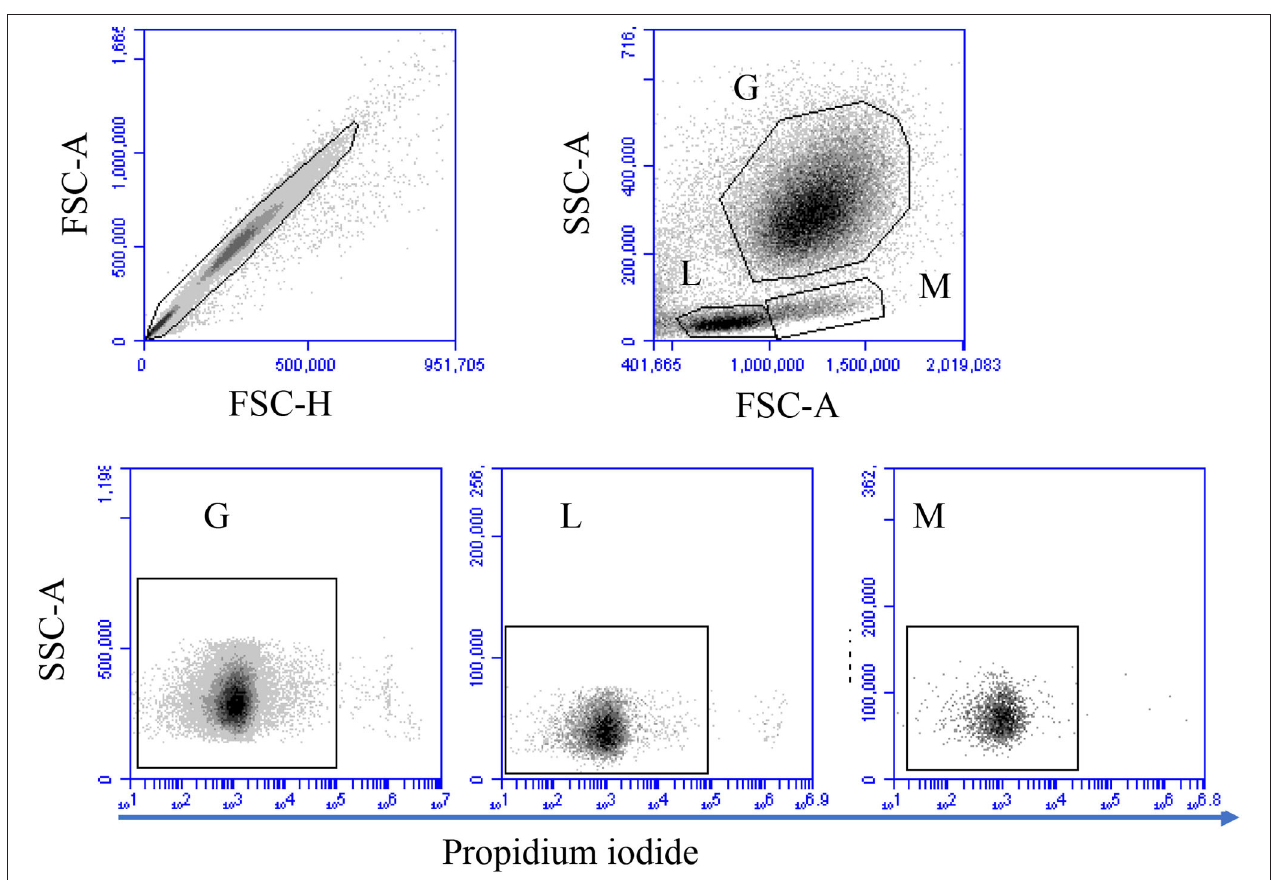
FIGURE 1 | Gating strategy for flow cytometric analysis of cell necrosis. Separated blood leukocytes were loaded with the DNA-sensitive dye propidium iodide (PI) and labeled cells were analyzed by flow cytometry. Cell duplicates were excluded using a FSC-H against FSC-A dot plot. After gating on single cells, camel granulocytes (G), lymphocytes (L), and monocytes (M) were identified based on their FSC and SSC properties. Viable (PI-negative cells) and necrotic (PI-permeable cells) were identified according to their staining with PI in a SSC-A against PI